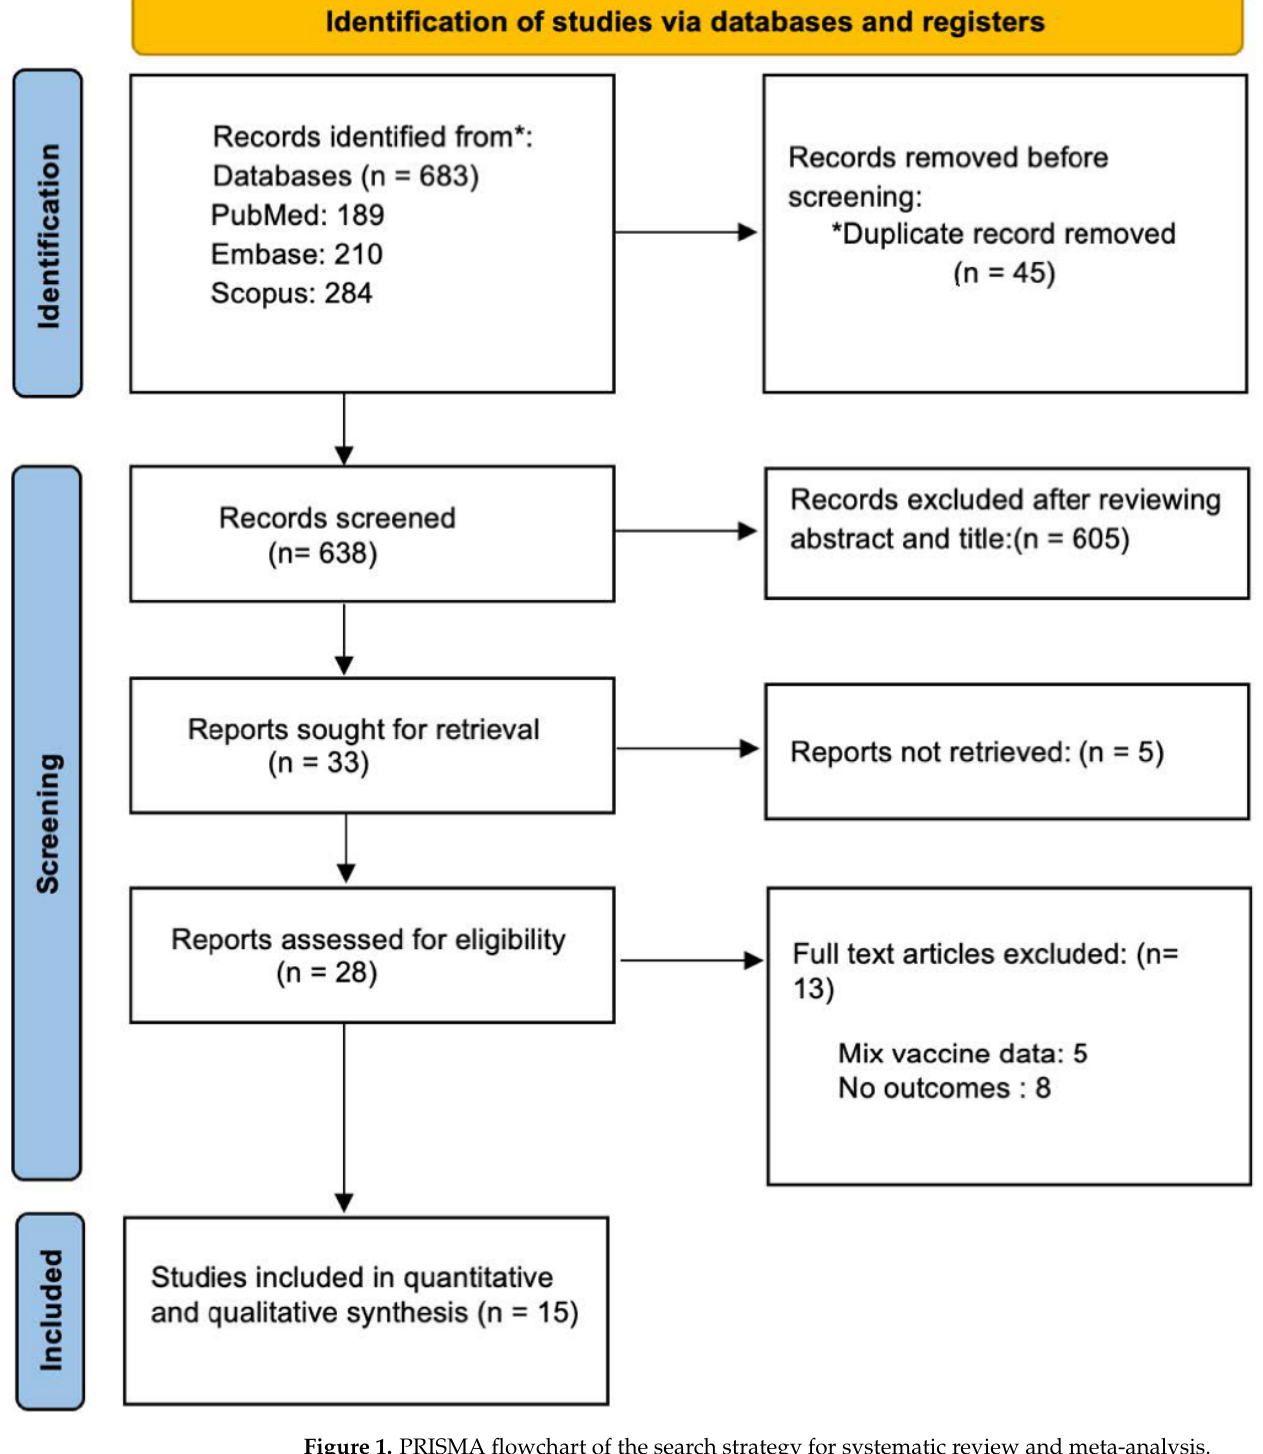
Figure 1. PRISMA flowchart of the search strategy for systematic review and meta-analysis.